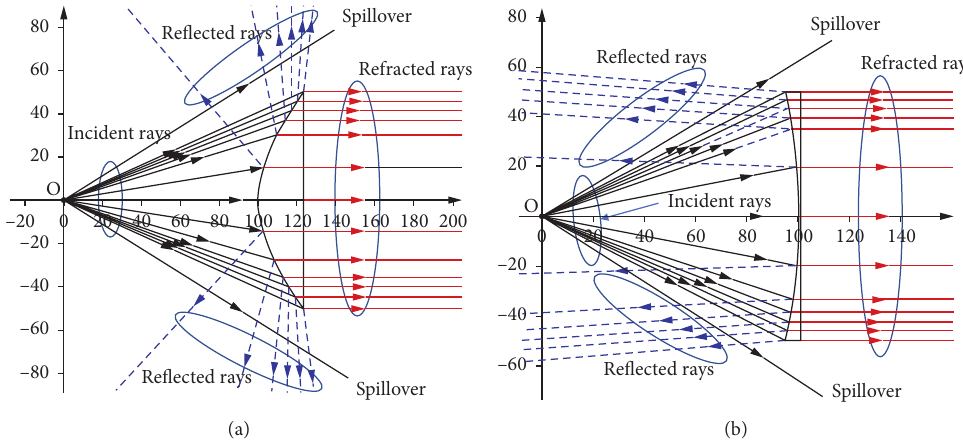
Figure 12: Multiple reflected rays on the curve lens antenna surface. (a) PRI lens. (b) NRI lens.